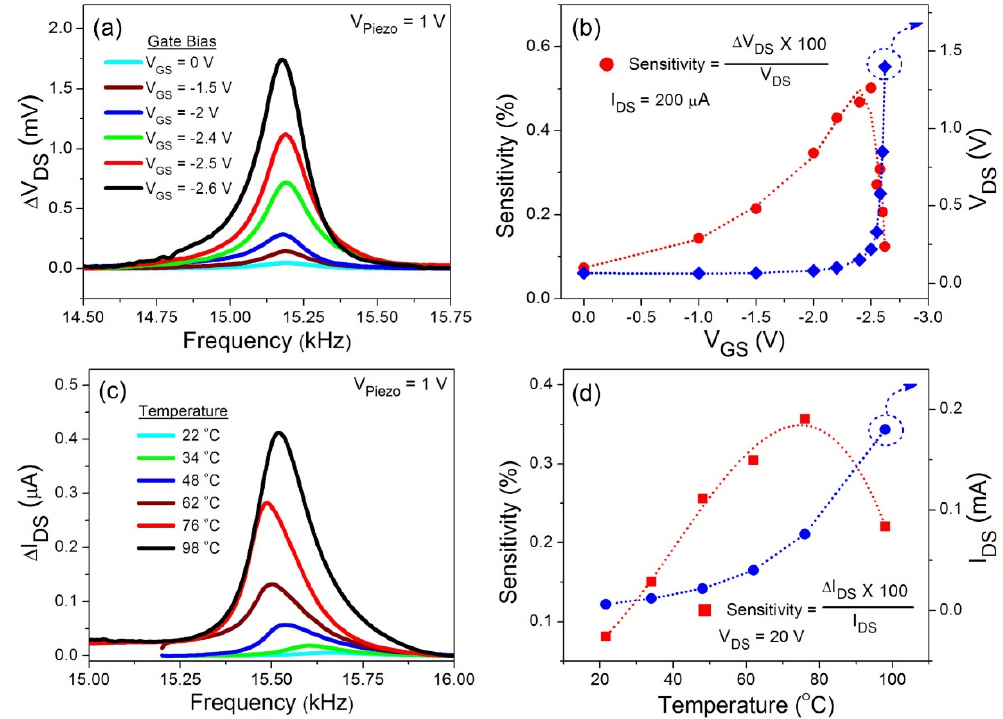
Figure 3. ( a ) Dynamic resonance characteristics of AlGaN / GaN HFET embedded GaN microcantilevers at various gate biases. An AC signal of 1 V was applied to the piezoactuator. ( b ) Calculation of the AlGaN / GaN HFET sensitivity changing with the gate bias, as shown in red circles. The HFET V DS variation due to the gate bias is shown in the right axis. ( c ) E ff ects of the temperature on the dynamic resonance behavior of the VO 2 thin film embedded GaN microcantilever, while the piezoactuator was biased at 1 V. ( d ) VO 2 thin film deflection sensitivity calculated at various temperatures. As the temperature increases, resistance of the VO 2 thin film reduces. Therefore, at a constant V DS of 20 V, I DS increases with temperature, as shown in the right axis.